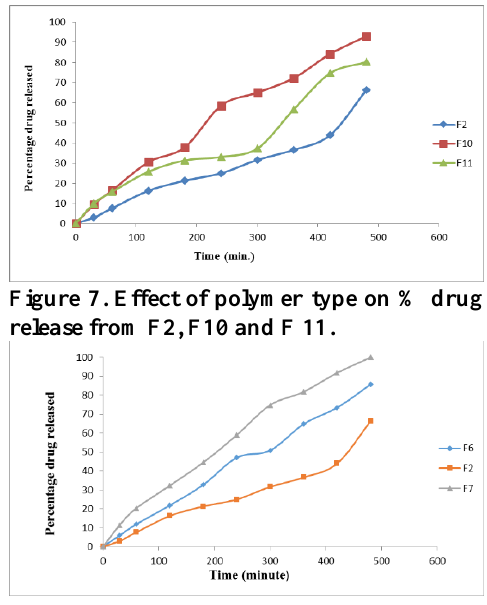
Figure 7. Effect of polymer type on % drug release from F2, F10 and F 11.